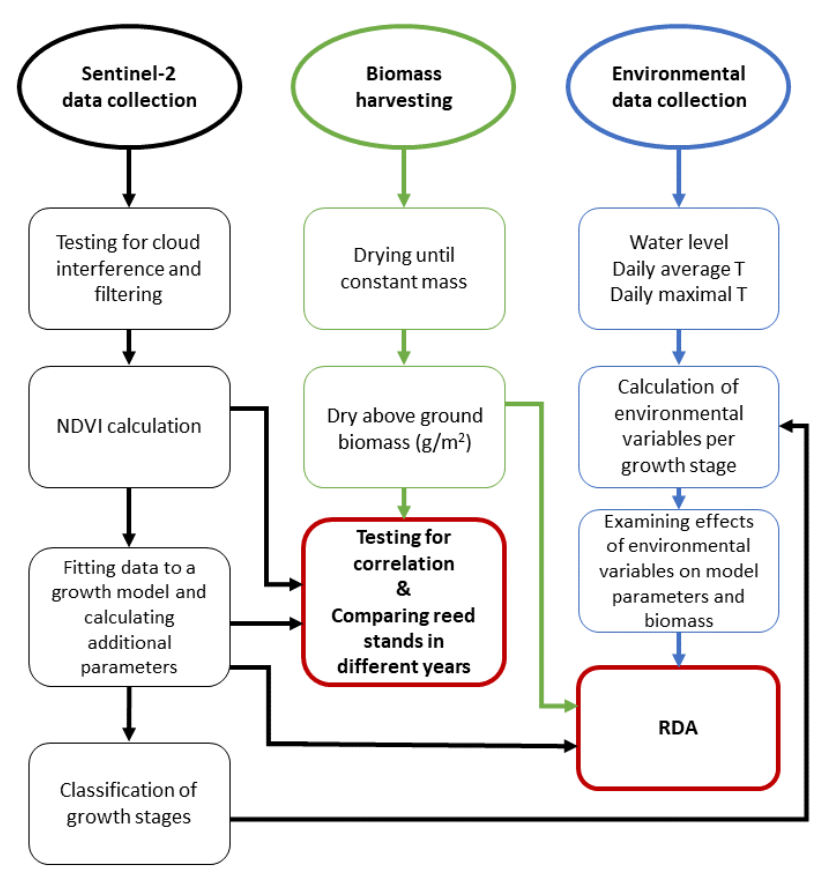
Figure 1. Workflow of this research. Red colored squares represent statistical analyses while the rest of the squares (black—remote sensing part, green—fieldwork part, blue—environmental data part) represent the steps that were adopted to achieve the results.